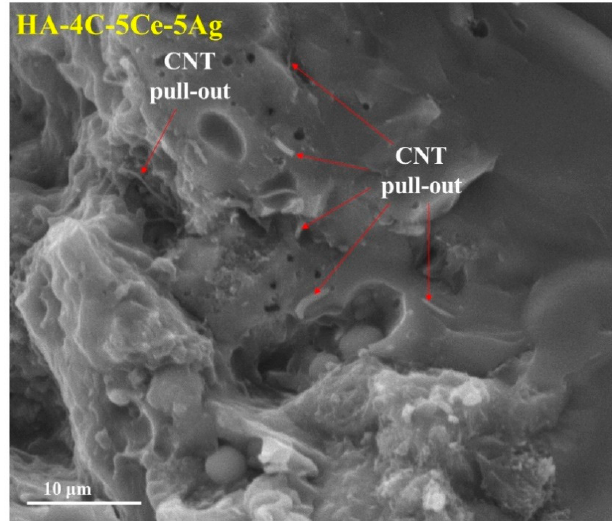
Figure 4. Fractured surface of HA-4C-5Ce-5Ag showing the CNT pull-outs.